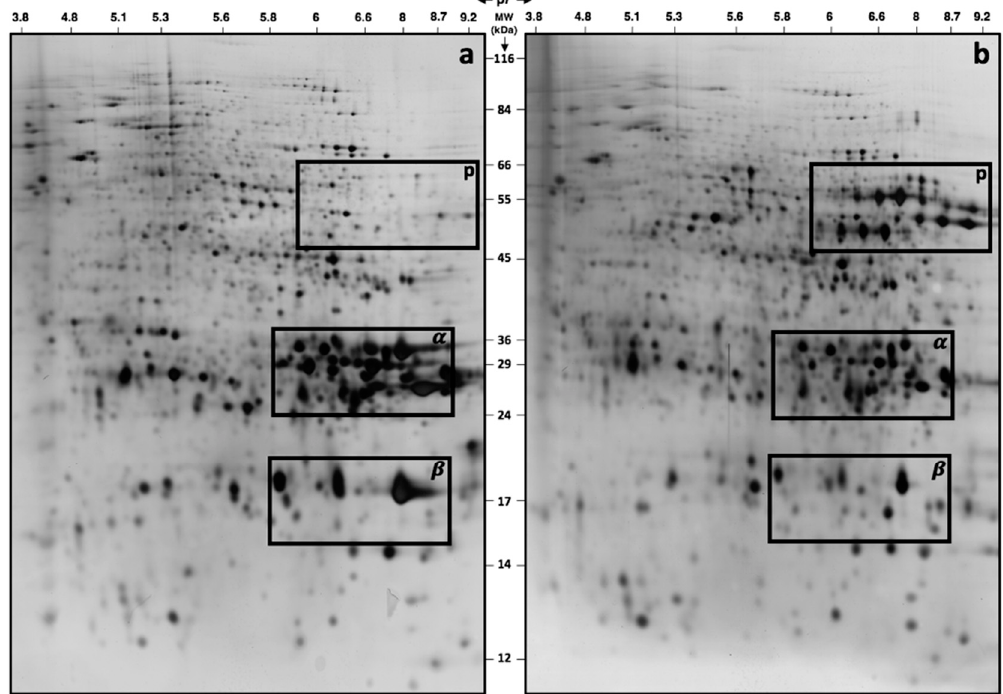
Figure 2. Influence of the retromer VPS29 mutation on Arabidopsis dry seed proteome. An equal amount (150 µ g) of total protein extracts was loaded on each gel. ( a ) A representative silver nitrate-stained 2DE gel of total soluble proteins from Col-0 ( Arabidopsis , accession Columbia-0; wild-type) dry mature seeds. ( b ) A representative silver nitrate-stained 2DE gel of total soluble proteins from vps29 dry mature seeds. The rectangles highlight the protein clusters of 12S storage protein precursors (p), 12S alpha-cruciferins ( α ), and 12S beta-cruciferins ( β ). MW, molecular weight; pI, isoelectric point.